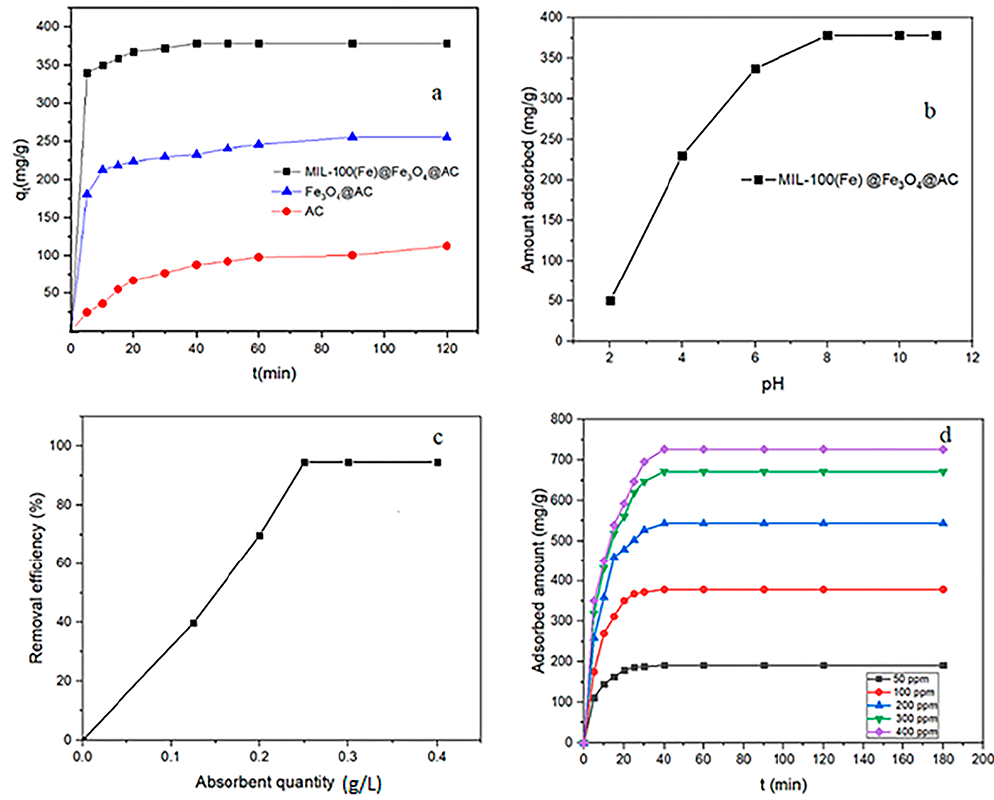
Figure 7. ( a ) Effect of surface modification on removal of RhB by AC, Fe 3 O 4 @AC, and MIL-100